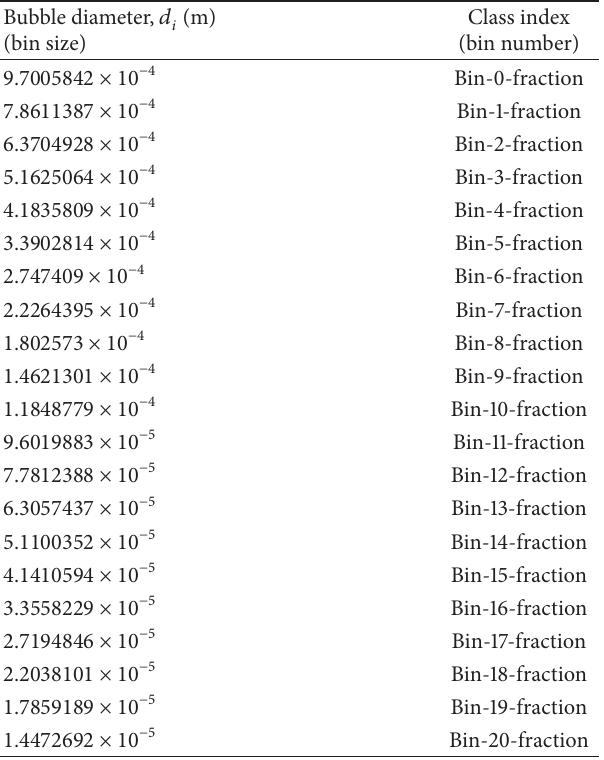
Table 2: Diameter of each bubble class tracked in the simulation. Bubble diameter, 𝑑 𝑖 (m)